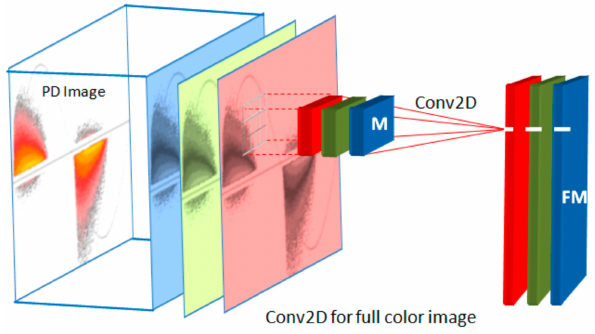
Figure 3. Creation of feature map for full-color image (FM—feature